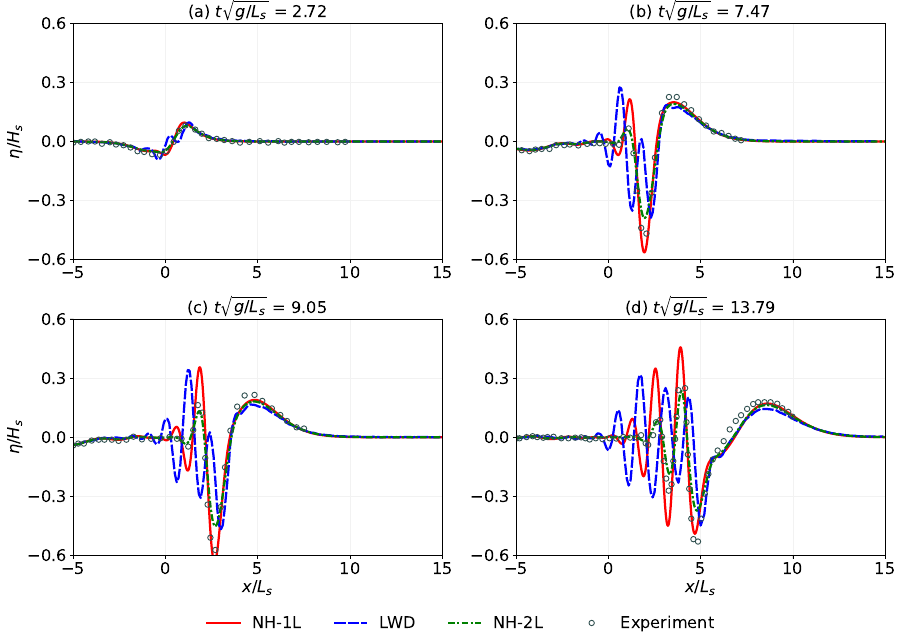
Figure 12. Comparisons of observed and predicted wave heights at several times in run